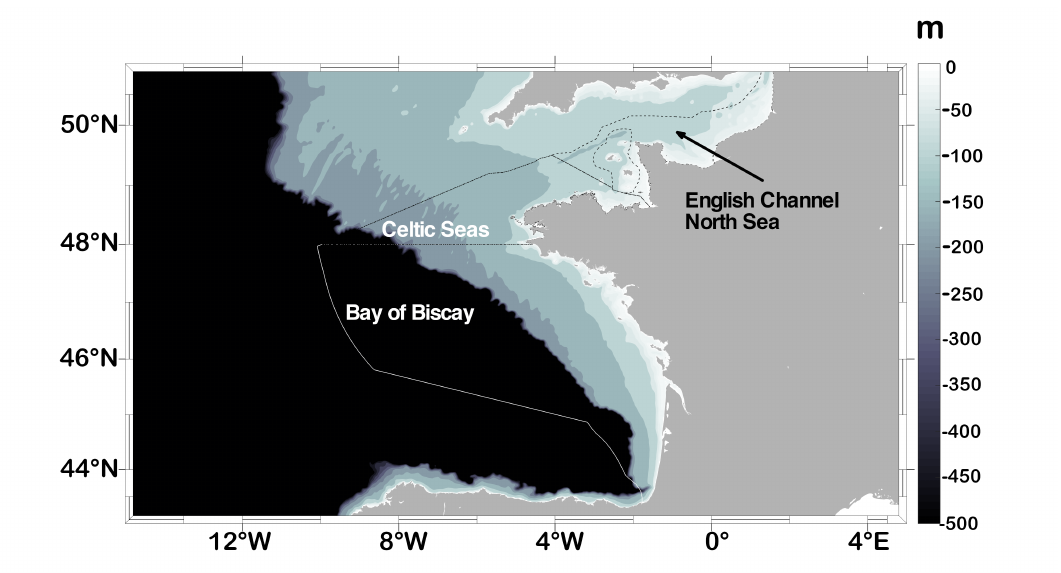
Figure 1. Map of the study area showing the bathymetry and French Marine Strategy Framework Directive (MSFD, Directive 2008/56/CE) sub-marine regions: Bay of Biscay (white line), East English Channel–North Sea (black dashed line), Celtic Seas (black dot-dashed